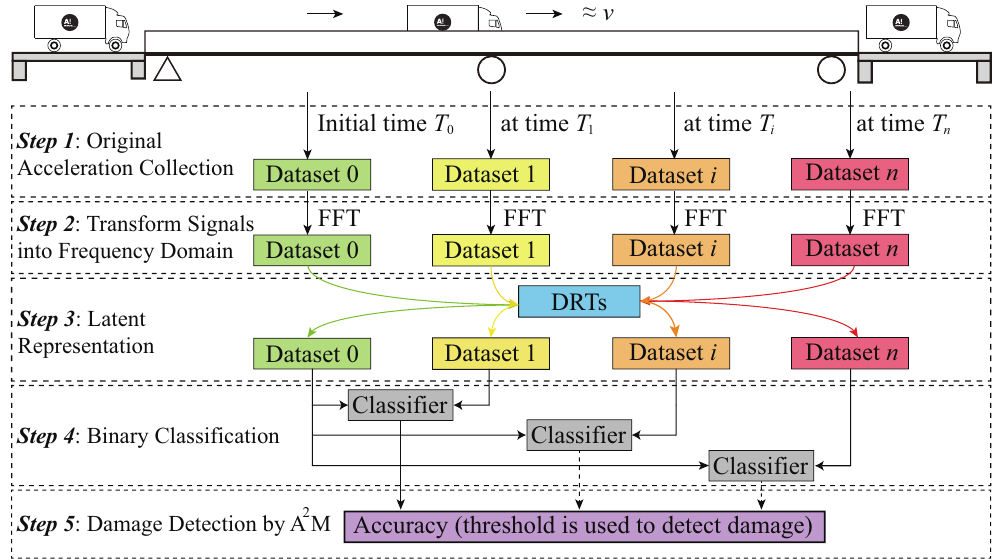
Figure 1. Schematic workflow of the proposed